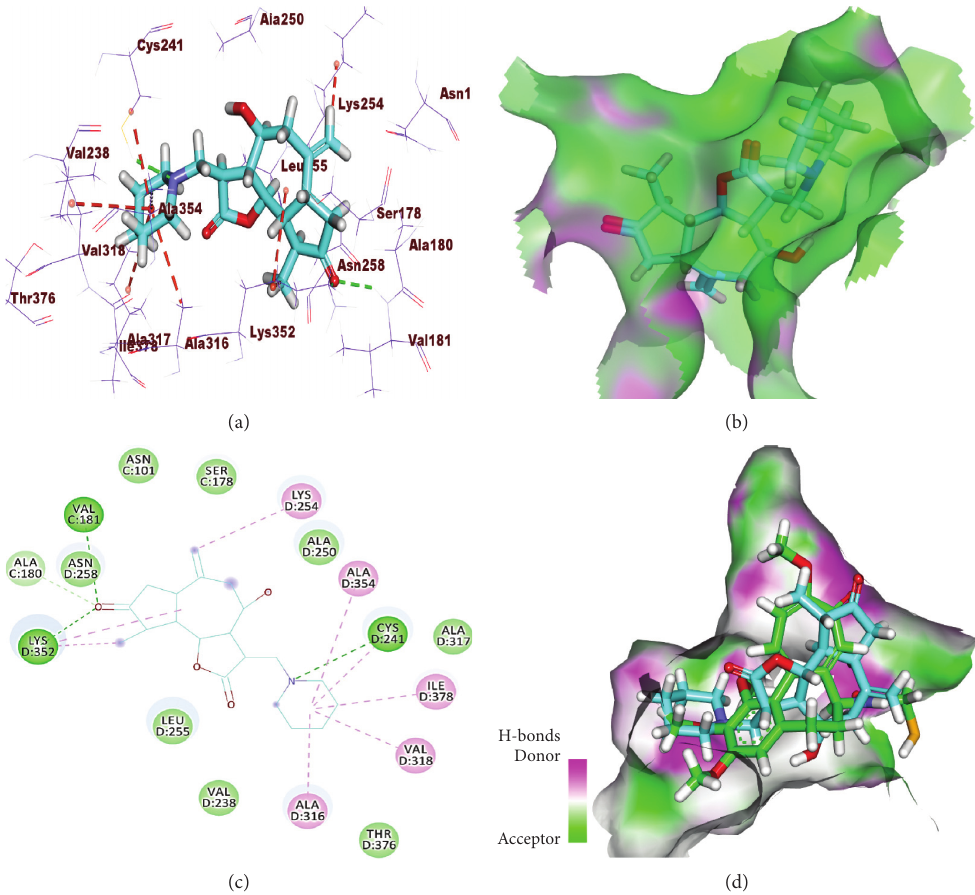
Figure 8: (a) 3D structure of compound 3, docked into the colchicine binding site. (b) Mapping surface showing compound 3, occupying the active pocket of colchicine binding site. (c) 2D structure of compound 3, docked into the colchicine binding site. (d) 3D alignment of compound 3 (carbon atoms in turquoise) with the DAMA-colchicine (carbon atoms in